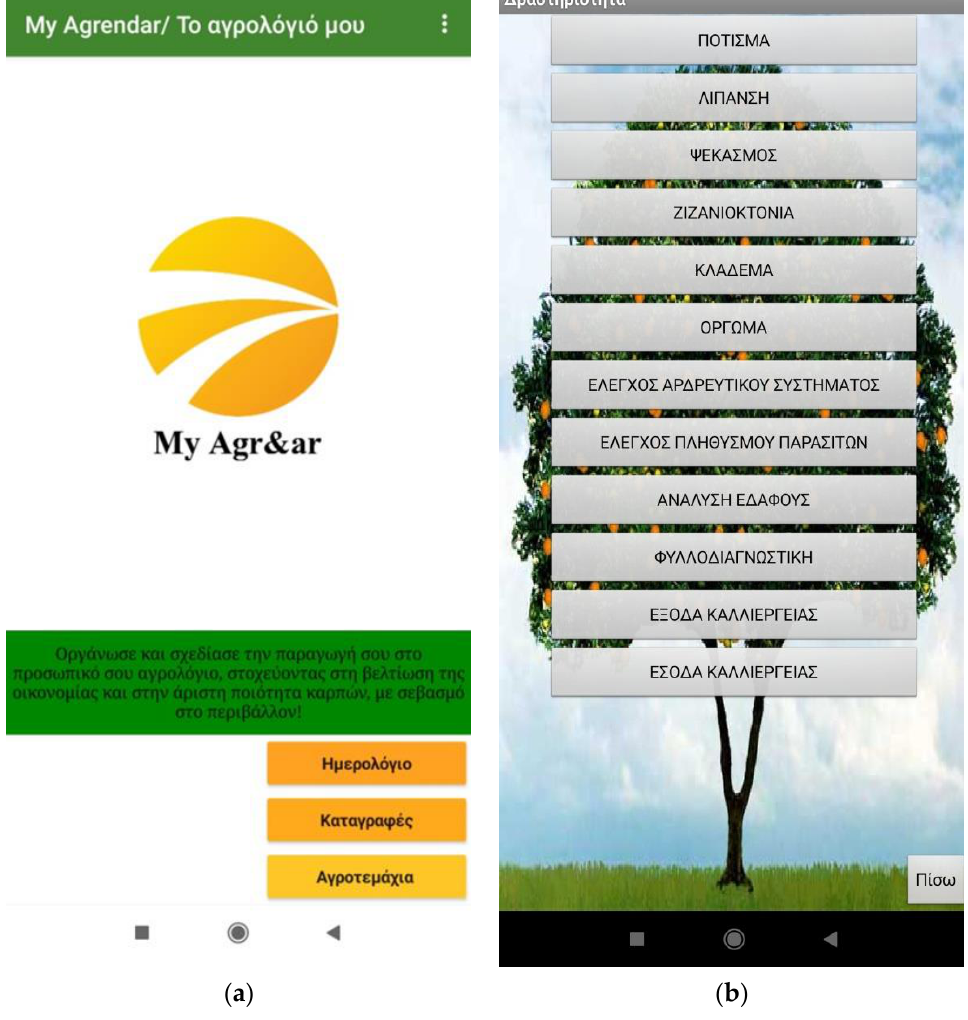
Figure 4. Agrendar: ( a ) Home screen, ( b ) List of farming activities screen. “Plots” functionality: From the “Plots” button, the user enters a new screen, from which they can create a new record using the “New Plot”. Special rules are activated when the user tries to submit incomplete or non-valid data. In this case, the app requests the user to provide the appropriate data to proceed. After a successful submission, the data are recorded in txt format on the smart mobile device and a confirmation message pops up on the screen. All new entries are stored, and the grower can view the content in the form of a